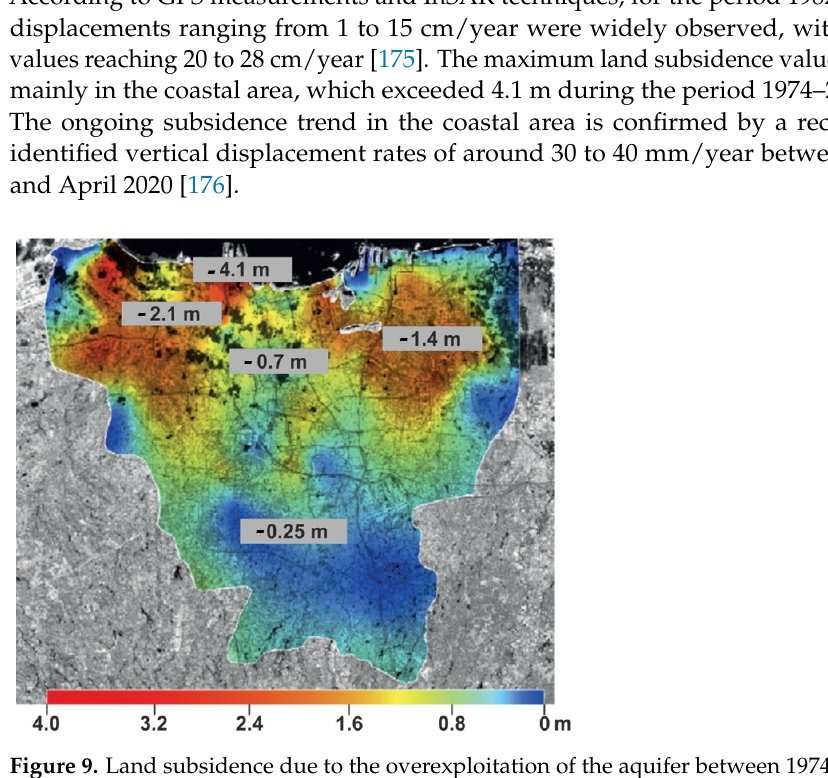
Figure 9. Land subsidence due to the overexploitation of the aquifer between 1974–2010 in Jakarta, Indonesia [177] .